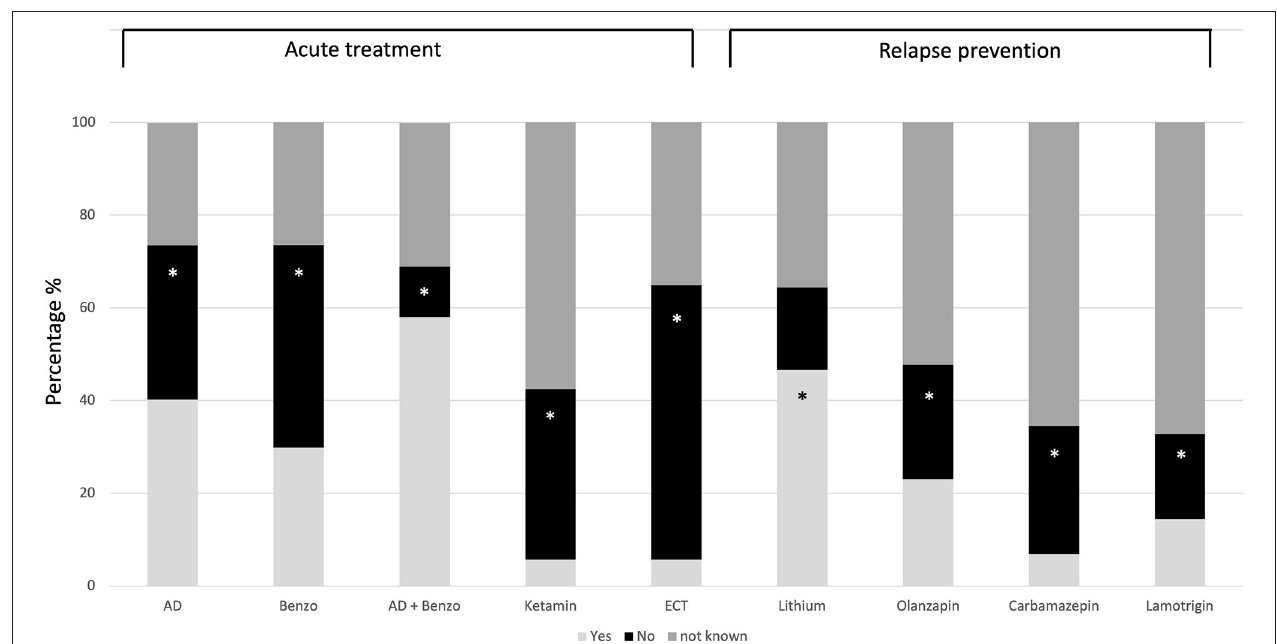
FIGURE 1 | Response pattern to pharmacological treatment recommendations. The correct answer option is marked with a star ( * ). AD, Antidepressants; Benzo, Benzodiazepines; ECT, Electroconvulsive therapy; Yes, Should be used in treating suicidal patients; No, Should not be used in treating suicidal patients.